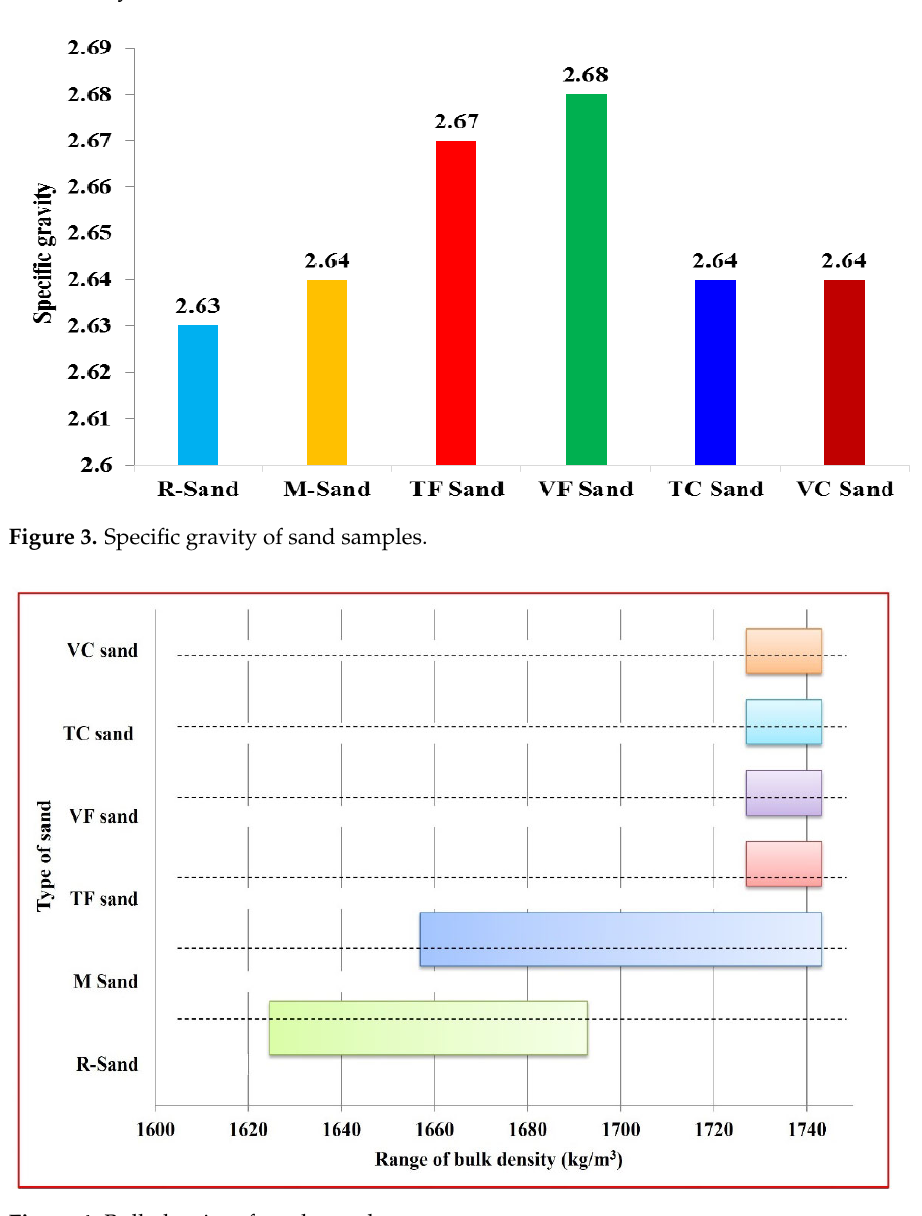
Figure 4. Bulk density of sand